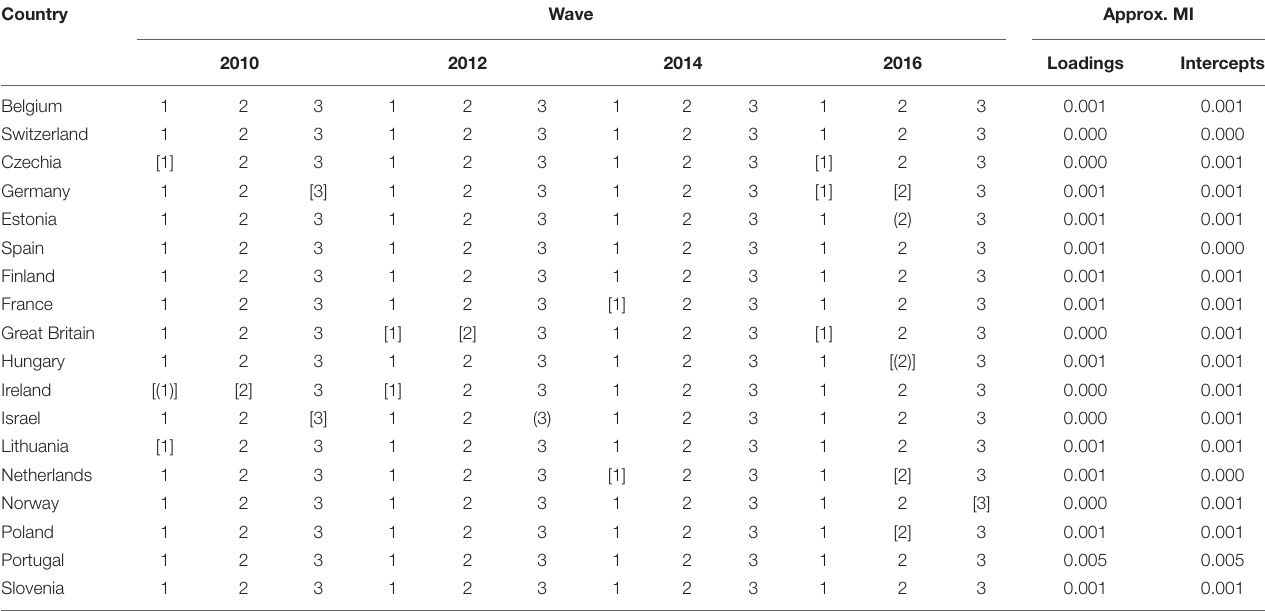
TABLE 2 | Invariance analysis of the general threat index.